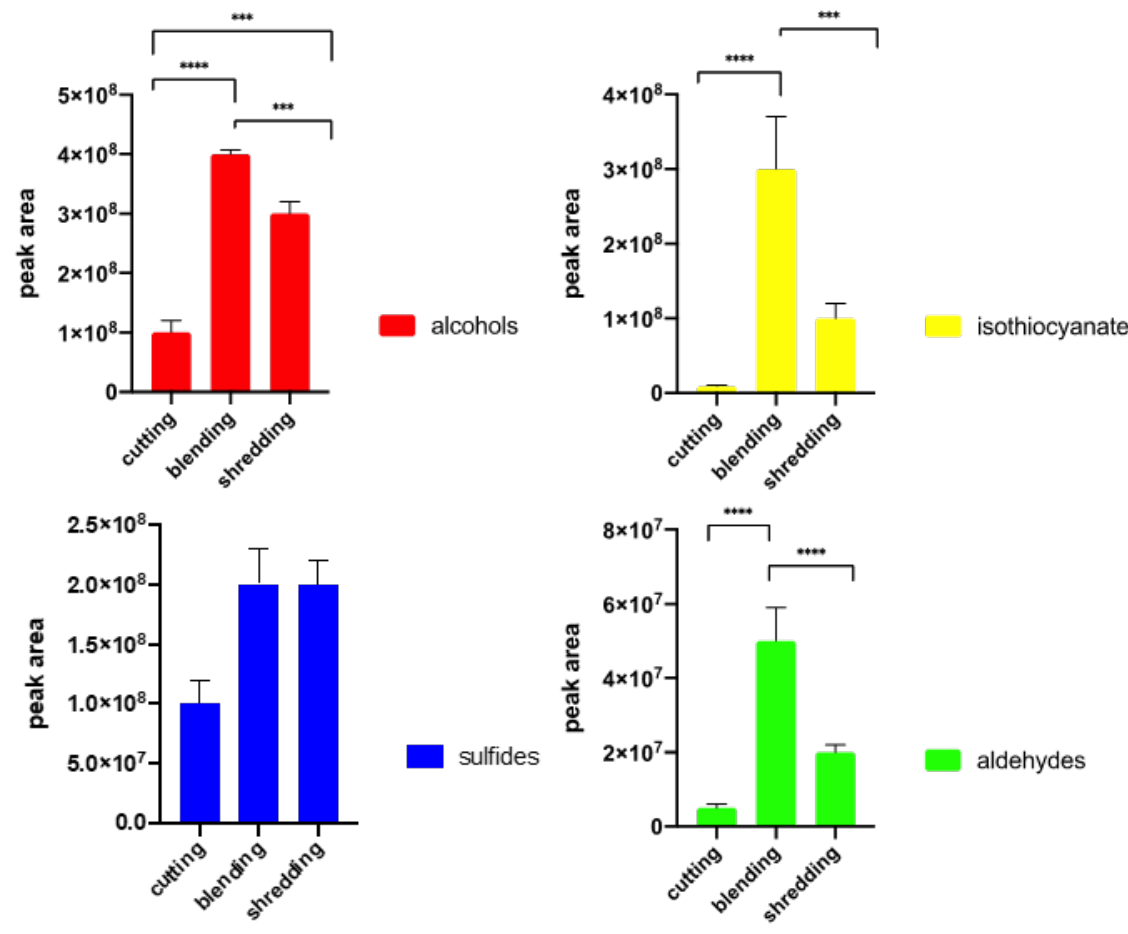
Figure 5. Influence of broccoli florets preparation on the number of extracted volatiles by SPME. Each bar graph is expressed as mean value ± standard deviation. *** p ≤ 0.001, **** p ≤ 0.0001 (according to the ANOVA test—Turkey’s test).